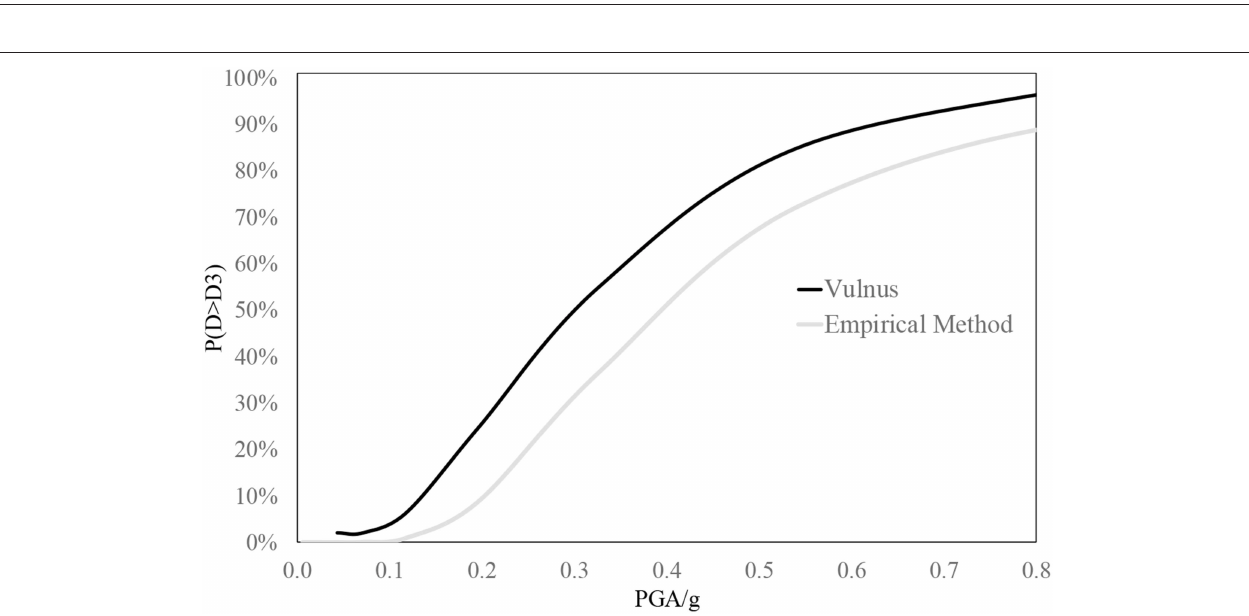
FIGURE 17 | The fragility curves given by Vulnus for a damage grade higher than D3.